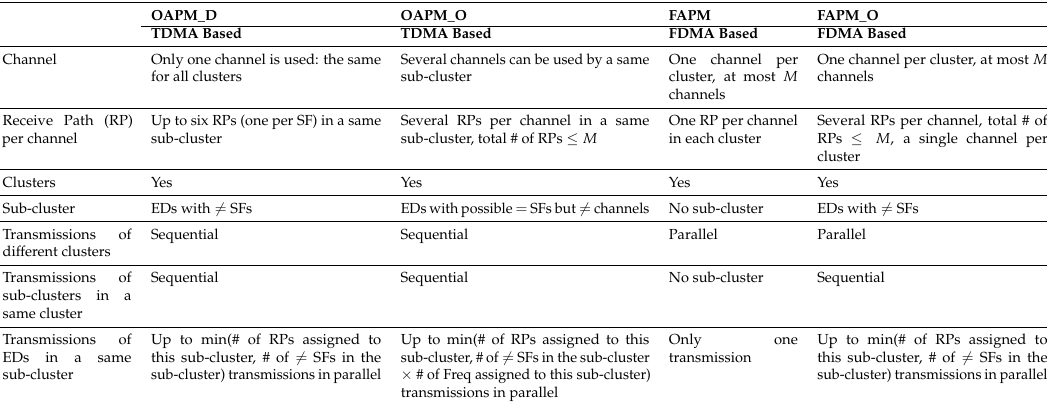
Table 4. Differences between OAPM_D and